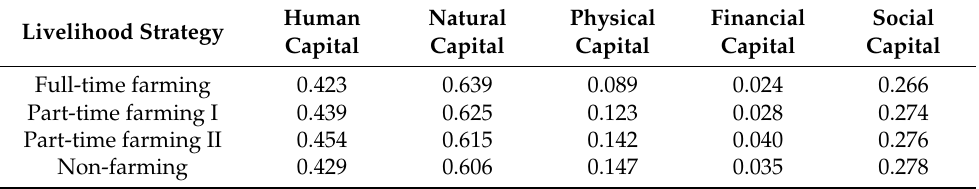
Table 5. Differences in the livelihood assets of households with different livelihood strategies.